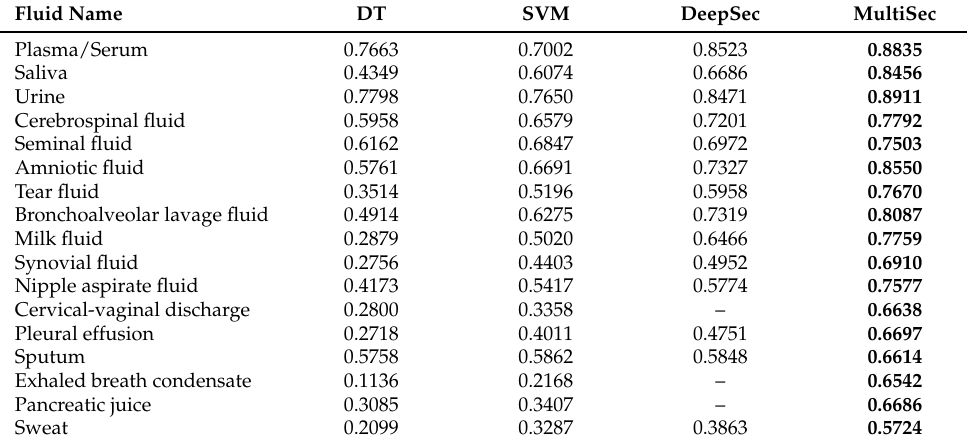
Table A4. F1 benchmarks of MultiSec and compared methods on the independent testing datasets of 17 human body fluids.